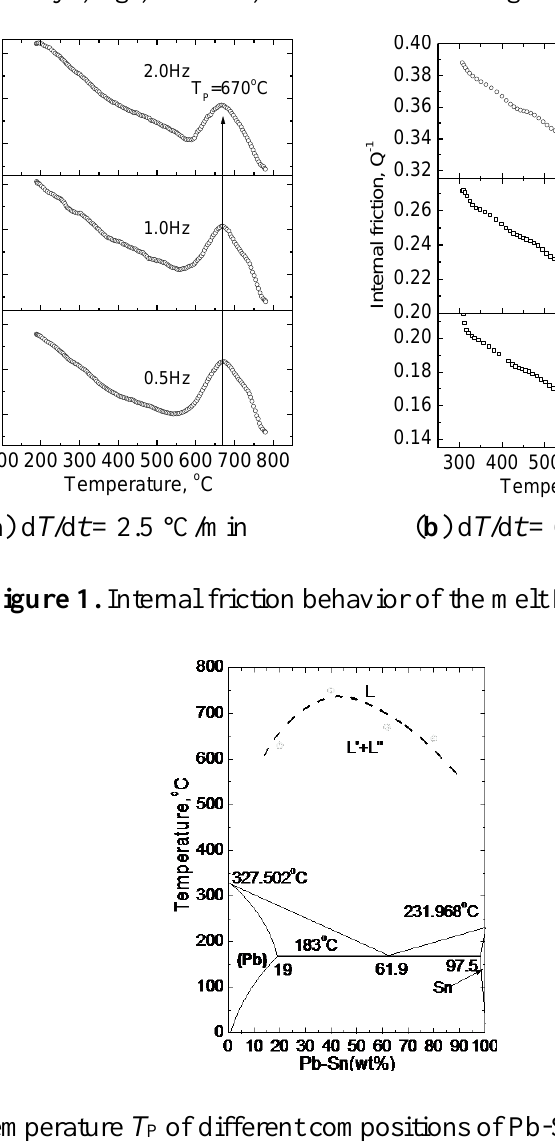
Figure 2. The temperature T P of different compositions of Pb-Sn during heating process.